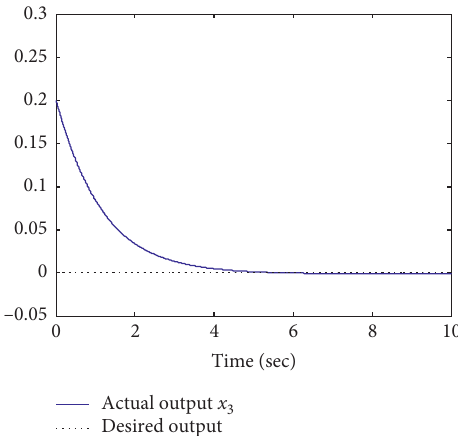
Figure 6: Trajectories of the second output x controller